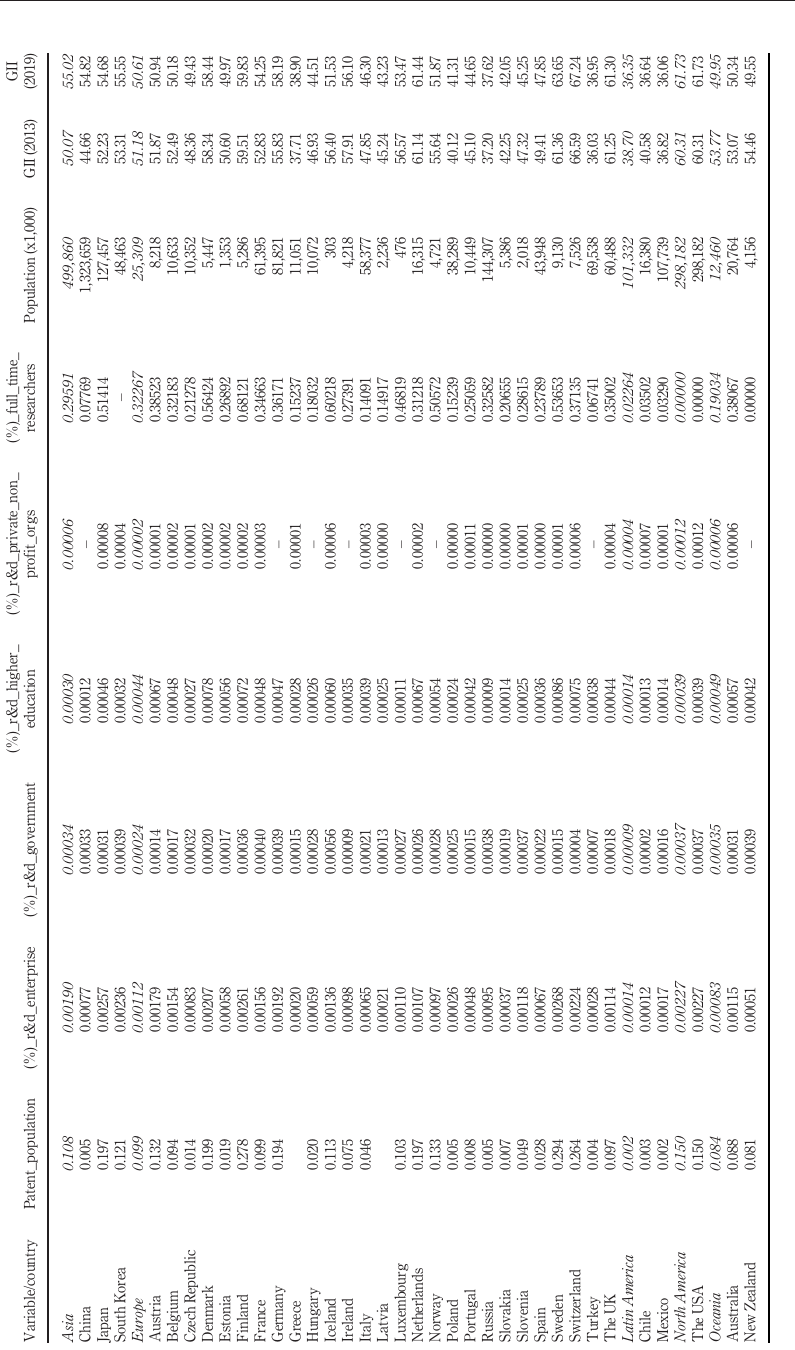
Table 1. Characteristics of the sample (avg. 1999 to 2013, and GII 2013 and